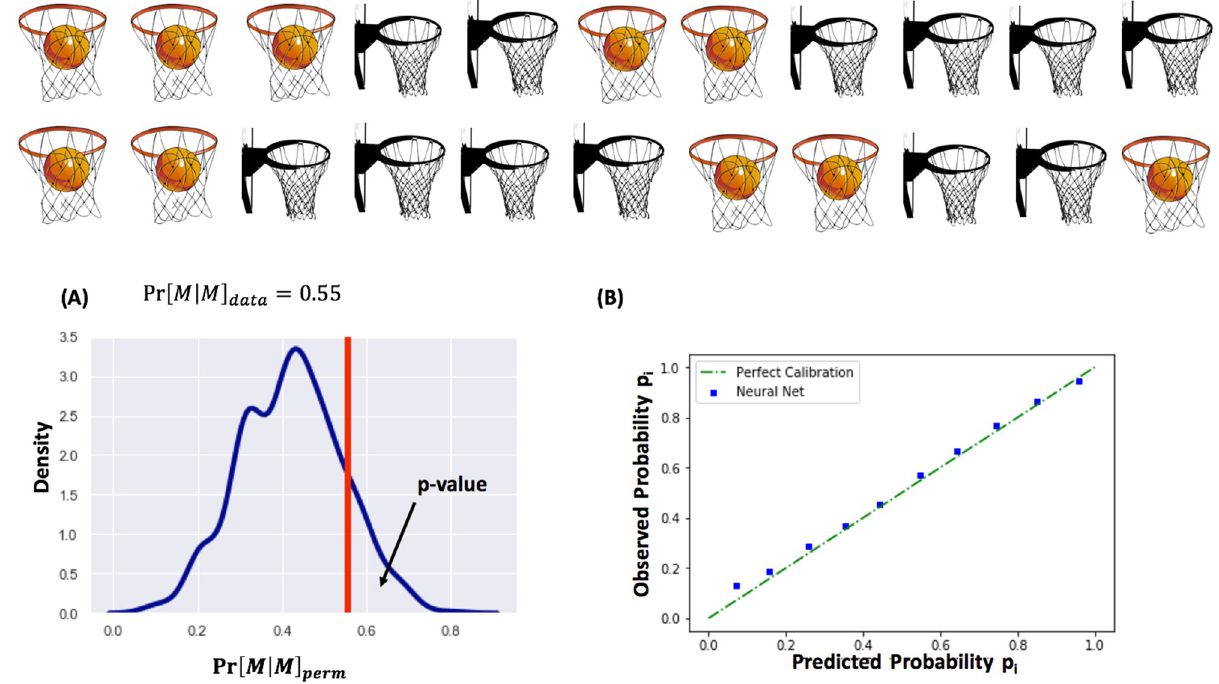
Fig 1. (A) The permutation test [6] removes the streak selection bias in small sequences. (B) In an actual game environment we need to consider the shot quality. Our shot make probability model outputs accurate out-of-sample probabilities.